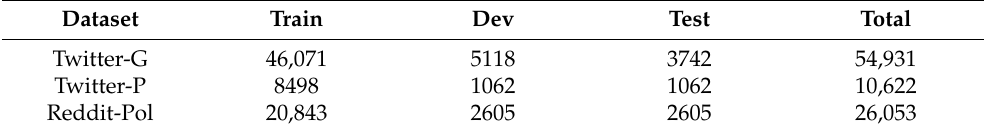
Table 1. Statistics of the